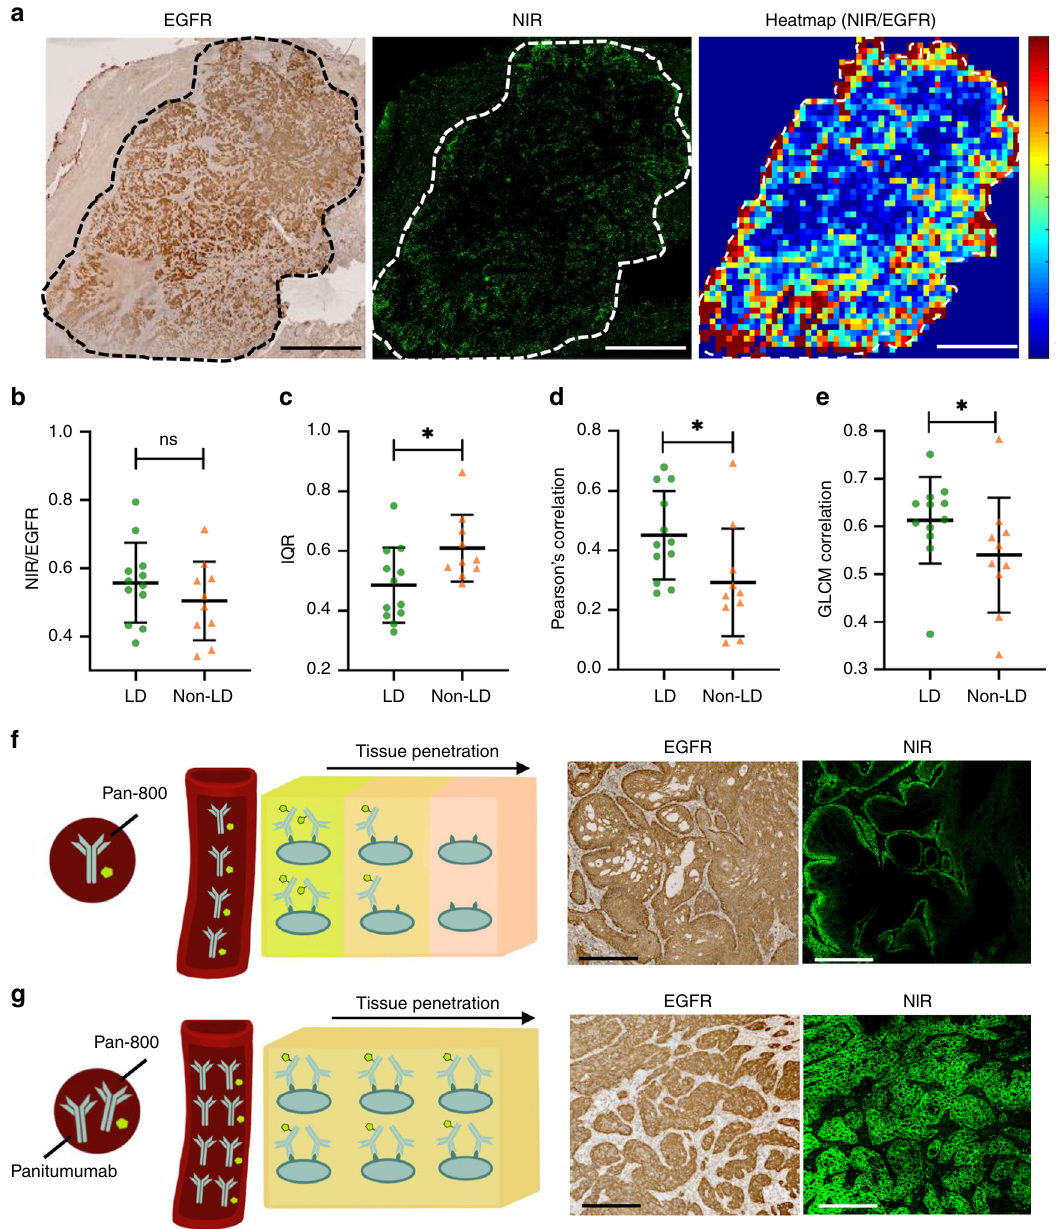
Fig. 5 Antibody – dye has more homogenous spatial distribution across tumor when co-administered with the unlabeled antibody. a Each tumor was gridded into small square regions and antibody penetration within each square region was quanti fi ed as the ratio of fl uorescent positive area to EGFR- positive area. b The ratio of fl uorescence to EGFR over the entire tumor area was not signi fi cantly different between the LD and non-LD group (Scale bar: 5 mm). c – e Comparison of three metrics, including interquartile range (IQR), Pearson ’ s correlation coef fi cient between fl uorescence and EGFR expression and CLCM correlation, all re fl ected less heterogeneity in antibody penetration across tumors in patients with loading dose (* p < 0.05; ns: p > 0.05). f , g Co- administration of parent antibody could overcome binding site barrier and improve antibody – dye distribution within the tumors. f As fl uorescent antibody extravasates from blood vessels (red tube), it immediately binds EGFR in the tissue (represented by cells in the cube). g By co-administering non- fl uorescent antibody, the same amount of fl uorescent antibody reaches the tissue, but these antibodies compete for binding sites locally in the tissue. This results in improved distribution of fl uorescent antibody at the microscopic scale (Scale bar: 250 μ m). Mann – Whitney U test (two-tailed) was used in b – e . p value = 0.025 c , 0.025 d , 0.036 e . The number of independent patient samples available for b – e : n = 12 patients in the LD group and n = 10 in the non-LD group. Graphs plotted mean with standard no difference was found between the LD and non-LD dosing correlation coef fi cient between the fl uorescence and the EGFR groups (Fig. 5b). However, when taking into account the micro- expression of the square regions across each tumor was sig- regional variations using the square regions, the IQR of region- ni fi cantly higher in the LD than the non-LD dose group (Fig. 5d). based antibody penetration ratio across the tumor section was Moreover, the antibody penetration ratio of neighboring regions signi fi cantly lower in patients receiving a loading dose compared were signi fi cantly more correlated in tumors receiving the LD with the patients in the non-LD group (Fig. 5c) and the Pearson ’ s dose compared to tumors in the non-LD dose group (Fig. 5e). All